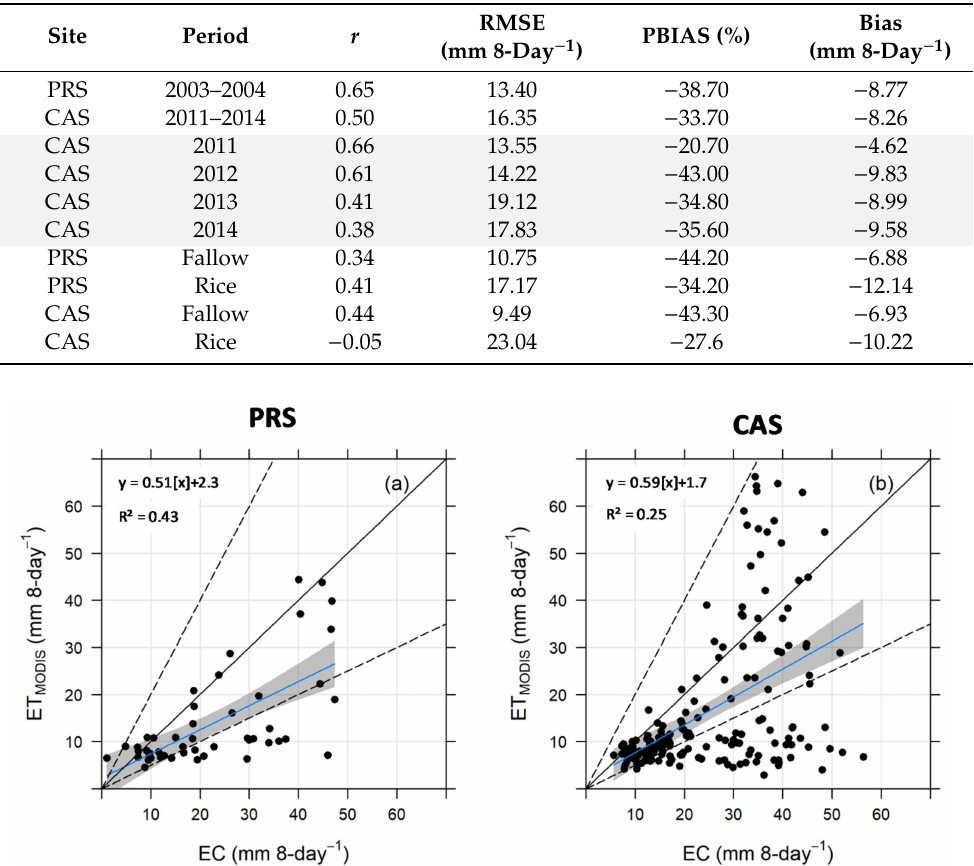
Figure 4. Scatterplots of the 8-day EC measurements against MOD16 ET estimates at PRS ( a ) and CAS ( b ). The solid blue lines represent the linear fit of the data and the grey areas represent the 95% confidence intervals. The line equations and R 2 value are also shown. For reference, the 1:1 line is solid black line and the 1:0.5 and 1:2 lines are